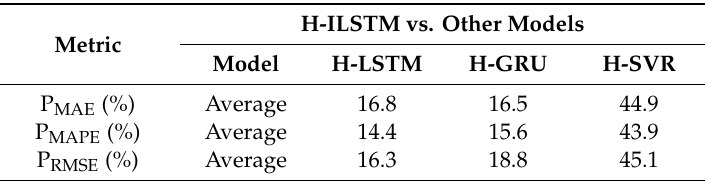
Table 14. The promoting percentages of the other models by the H-ILSTM model of the three-step prediction for the load datasets 1–4.